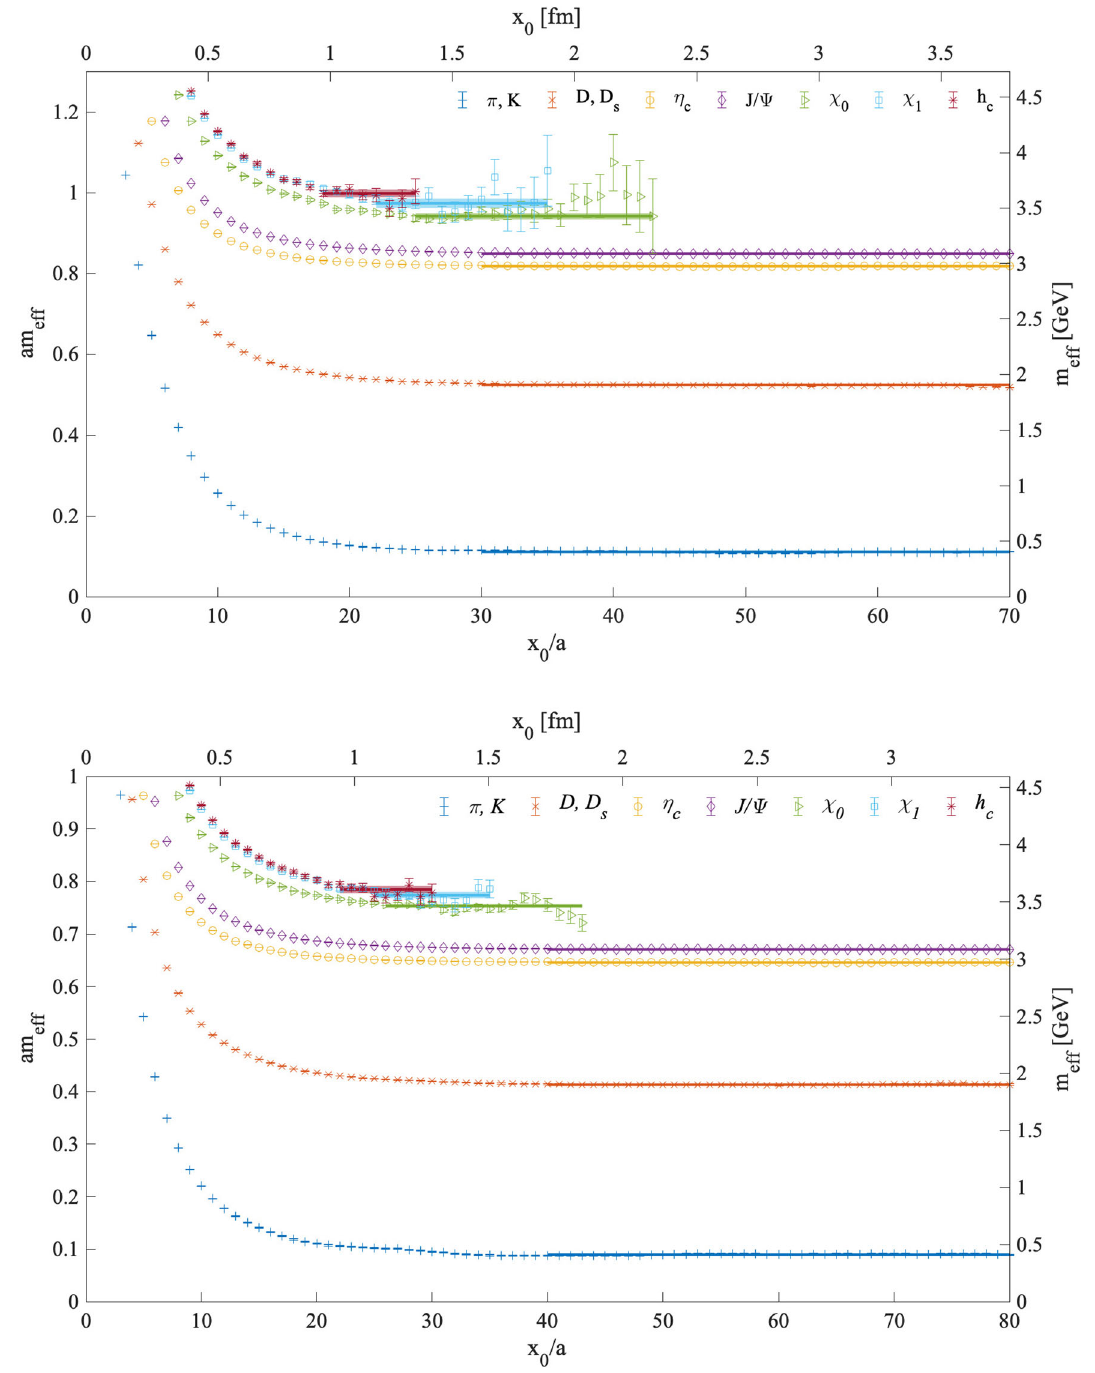
Fig. 5 Effective masses of the pion/kaon, D - and D s -meson, charmonium states η c , J /(cid:23) , χ 0 , χ 1 and h c (from bottom to top) on ensembles A2 (top) and B (bottom)